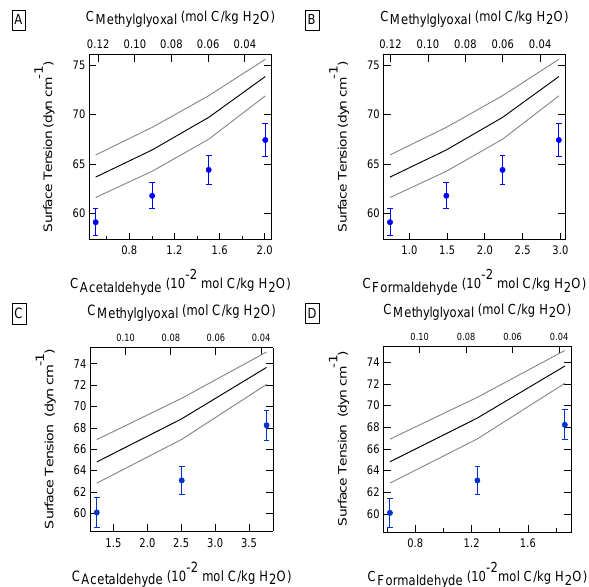
Figure 4 . Surface tension data for ternary (acetaldehyde, formaldehyde and MG) mix- Fig. 4. Surface tension data for ternary (acetaldehyde, formalde- tures in 3.1 M AS solutions. The molar ratios of acetaldehyde to formaldehyde are 1:3 hyde and MG) mixtures in 3.1MAS solutions. The molar ratios of (A and B) and 1:1 (C and D). The total organic concentration was constant at 0.05 M. acetaldehyde to formaldehyde are 1:3 ( A and B ) and 1:1 ( C and D ). The total organic concentration was constant at 0.05M. The black The black line shows Henning model predictions using the parameters listed in Table line shows Henning model predictions using the parameters listed 1. The grey lines show the confidence interval of the predicted data. in Table 1. The grey lines show the confidence interval of the pre- dicted data.